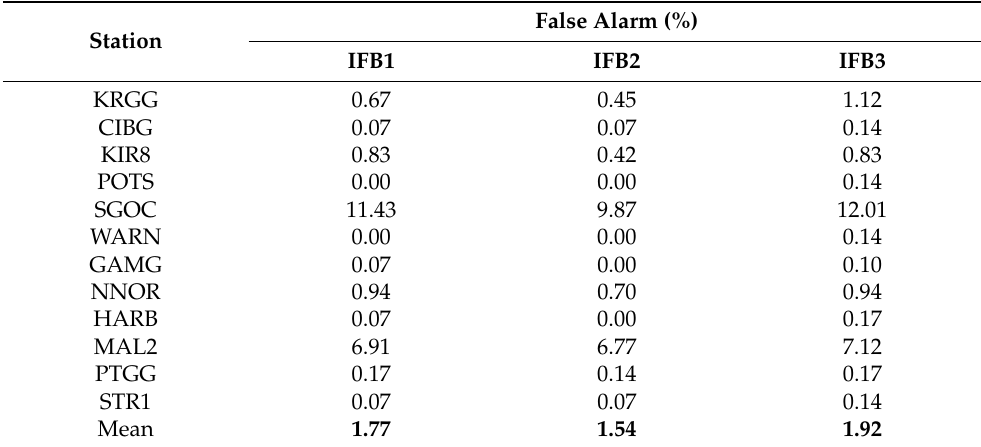
Table 5. False-alarm rate of overall test for three IFB stochastic modeling